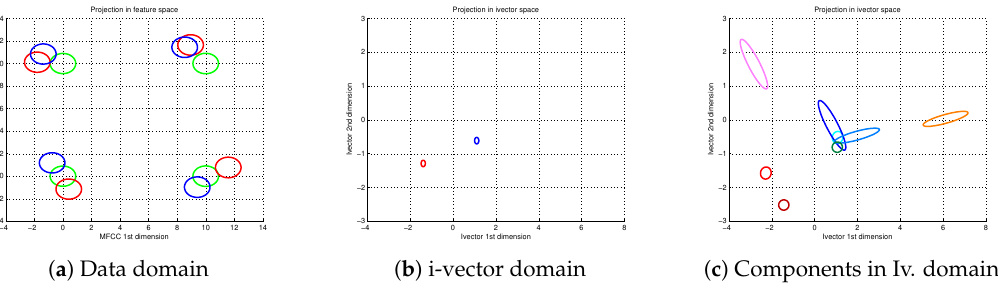
Figure 1. Scenario of interest. ( a ) Utterances red and blue in the feature domain, with the Universal Background Model (UBM) components in green; ( b ) Utterances red and blue in the i-vector domain; ( c ) Projections of the Gaussian Mixture Model (GMM) components in the i-vector domain for utterances red (reddish ellipses) and blue (bluish